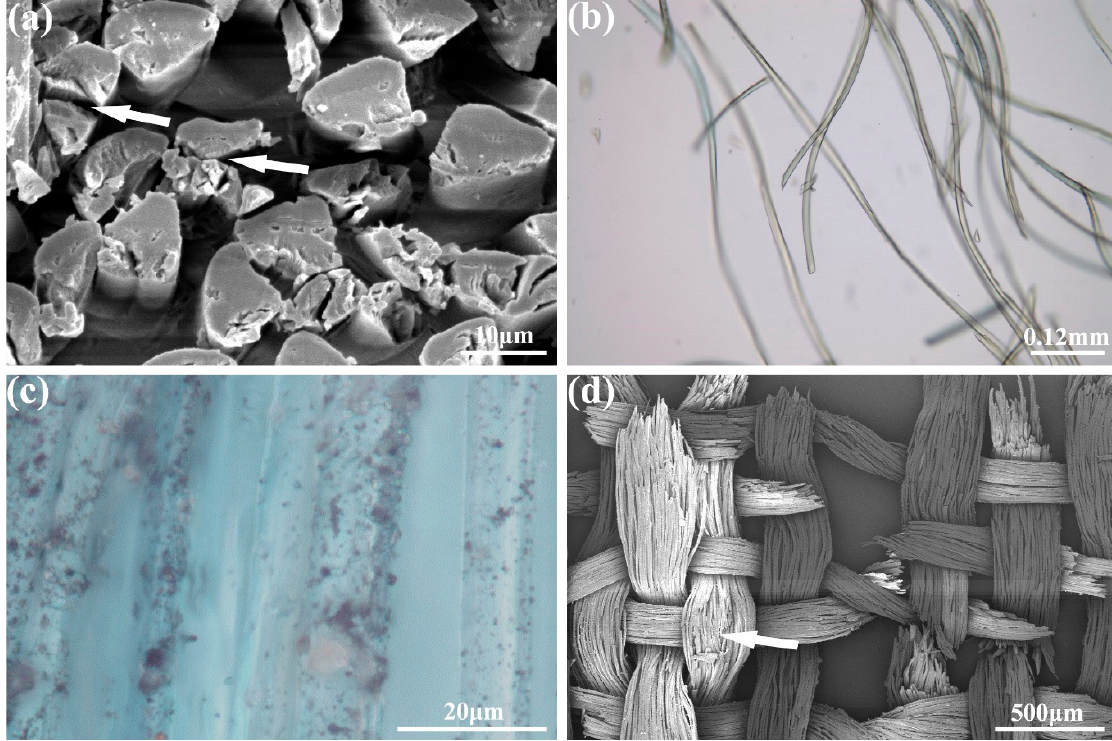
Figure 3. The fiber microphotographs under the SEM ( a ) ×2000; ( d ) ×50 and stereomicroscope ( b ) ×400; ( c ) ×4200, respectively (arrows show the damage, cracks, and fractures of the silk).